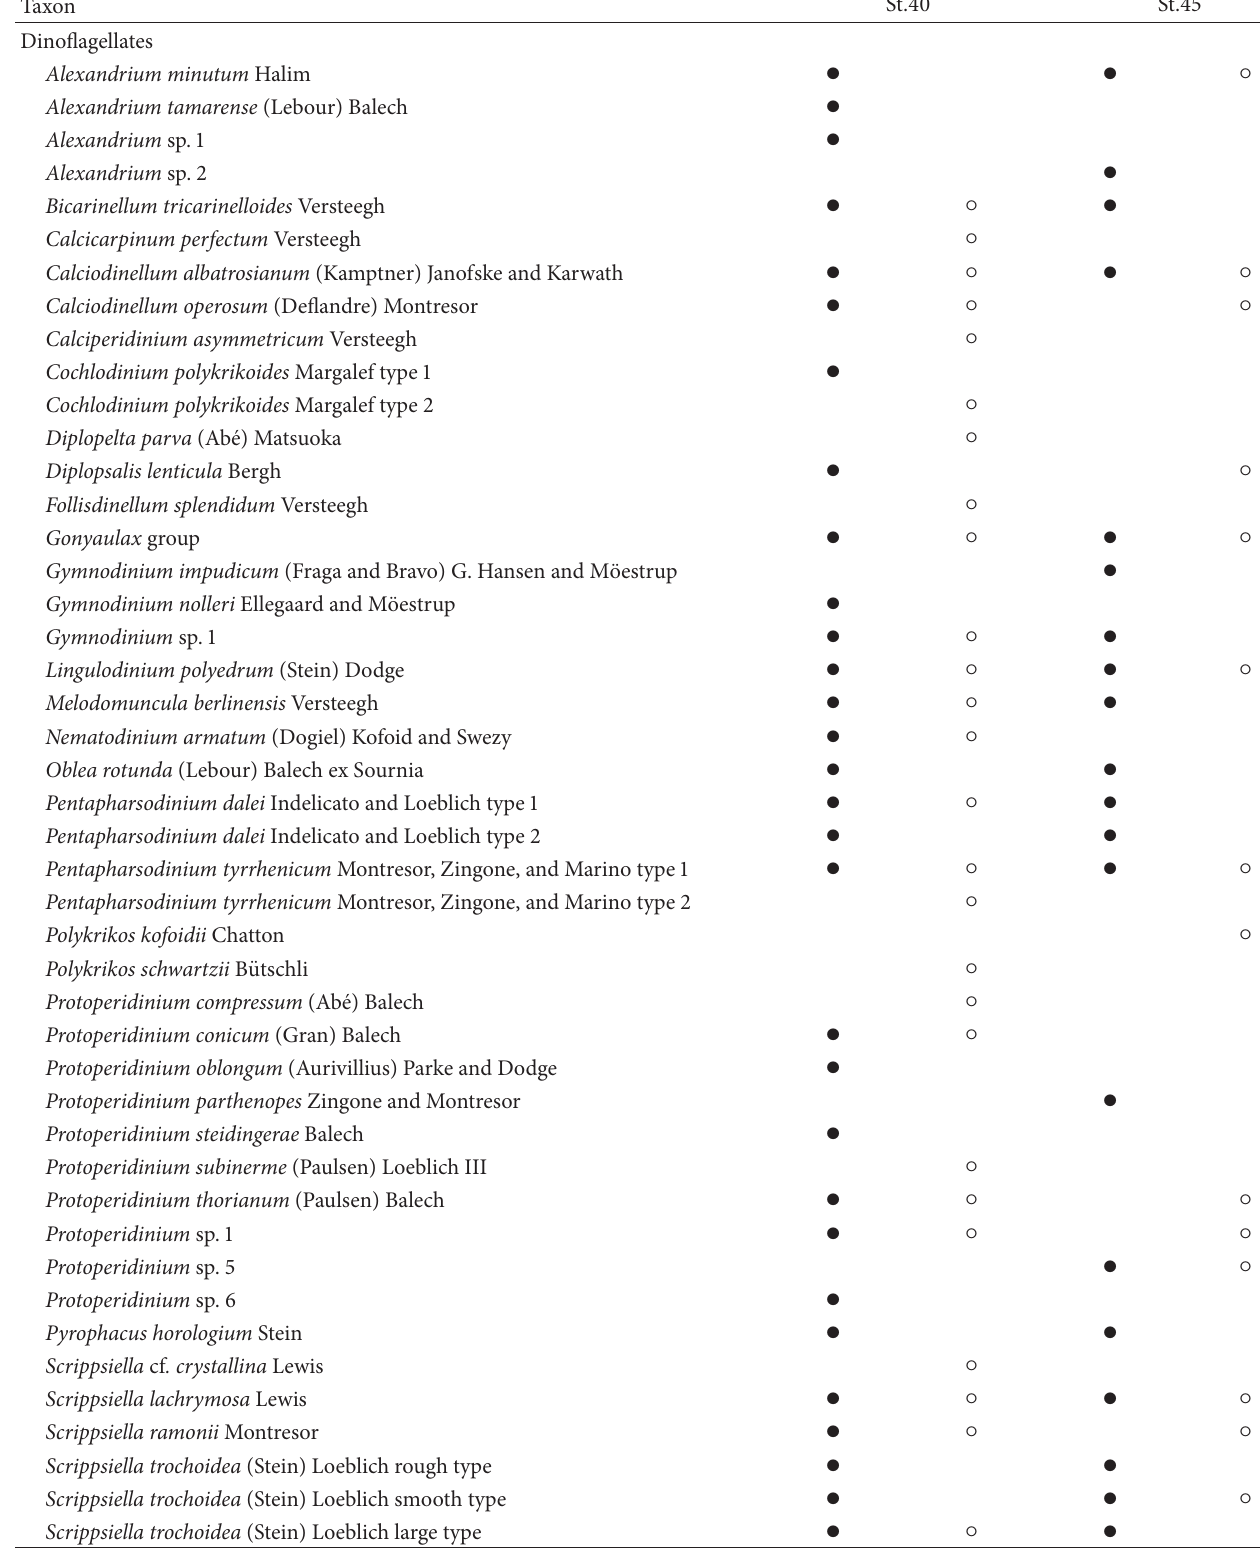
Table 1: List of resting stage (cyst) morphotypes recovered from sediments of Bay of Vlor¨e (Albania). Taxon St.40 St.45